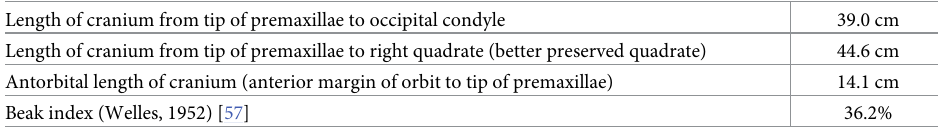
Length of cranium from tip of premaxillae to occipital condyle 39.0 cm Length of cranium from tip of premaxillae to right quadrate (better preserved quadrate) 44.6 cm Antorbital length of cranium (anterior margin of orbit to tip of premaxillae) 14.1 cm Beak index (Welles, 1952) [57]